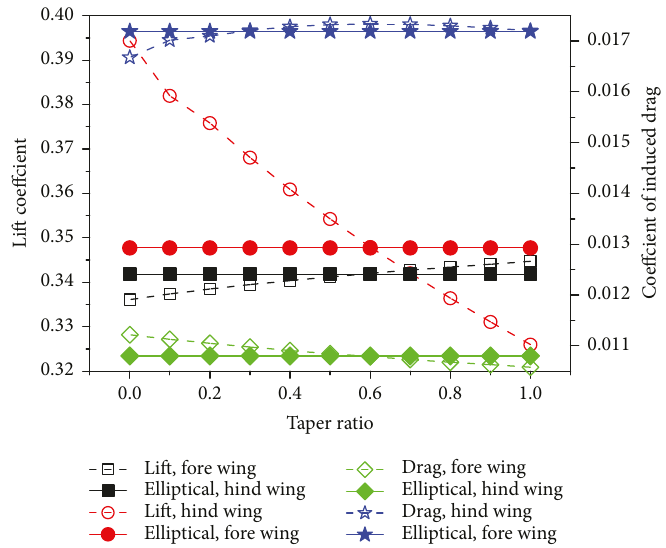
Figure 18: E ff ect of taper ratio on lift coe ffi cient and induced drag for tandem wing con fi guration.